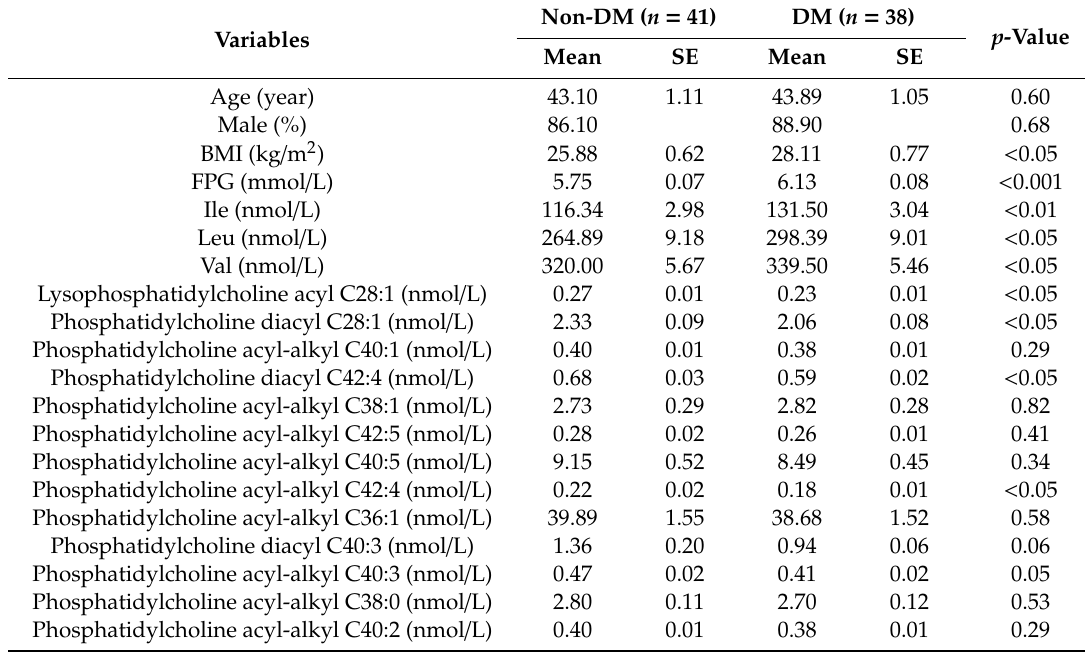
Table 3. The difference in clinical characteristics as well as baseline branched-chain amino acids (BCAAs) and LPCs whose VIP scores were > 1.5 according to diabetes (DM) status within 5 years. Note: BMI, body mass index; FPG, fasting plasma glucose.